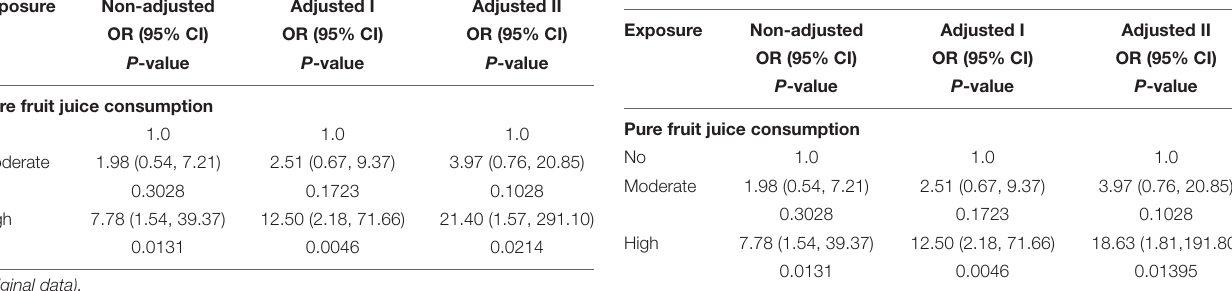
TABLE 5 | The relationship between 100% fruit juice consumption and late AMD. TABLE 6 | The relationship between 100% fruit juice consumption and late AMD (data after multi-imputation and